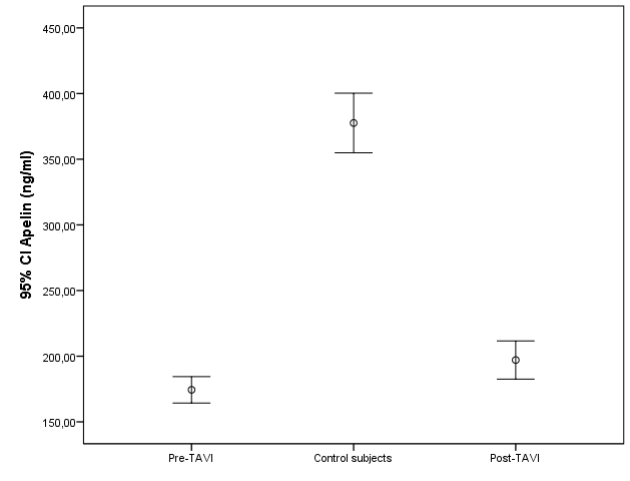
Fig. 1 – Comparison of serum apelin levels between control subjects and pre- and post-transcatheter aortic valve ımplantation (TAVI) procedure. CI=confidence